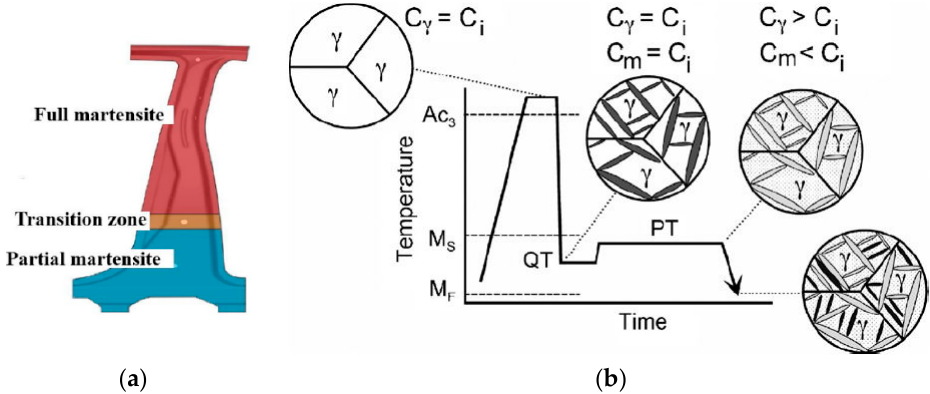
Figure 4. Advanced forming and quenching methods in hot stamping: two novel hot stamping processes for improving the final performance of hot-stamped parts: ( a ) Tailored microstructure (Adapted with permission from Elsevier [11]); ( b ) Quenching and partitioning process (reproduced with permission from Elsevier [42]) (C i , C γ , C m represent the carbon contents of the initial alloy, austenite and martensite, respectively).